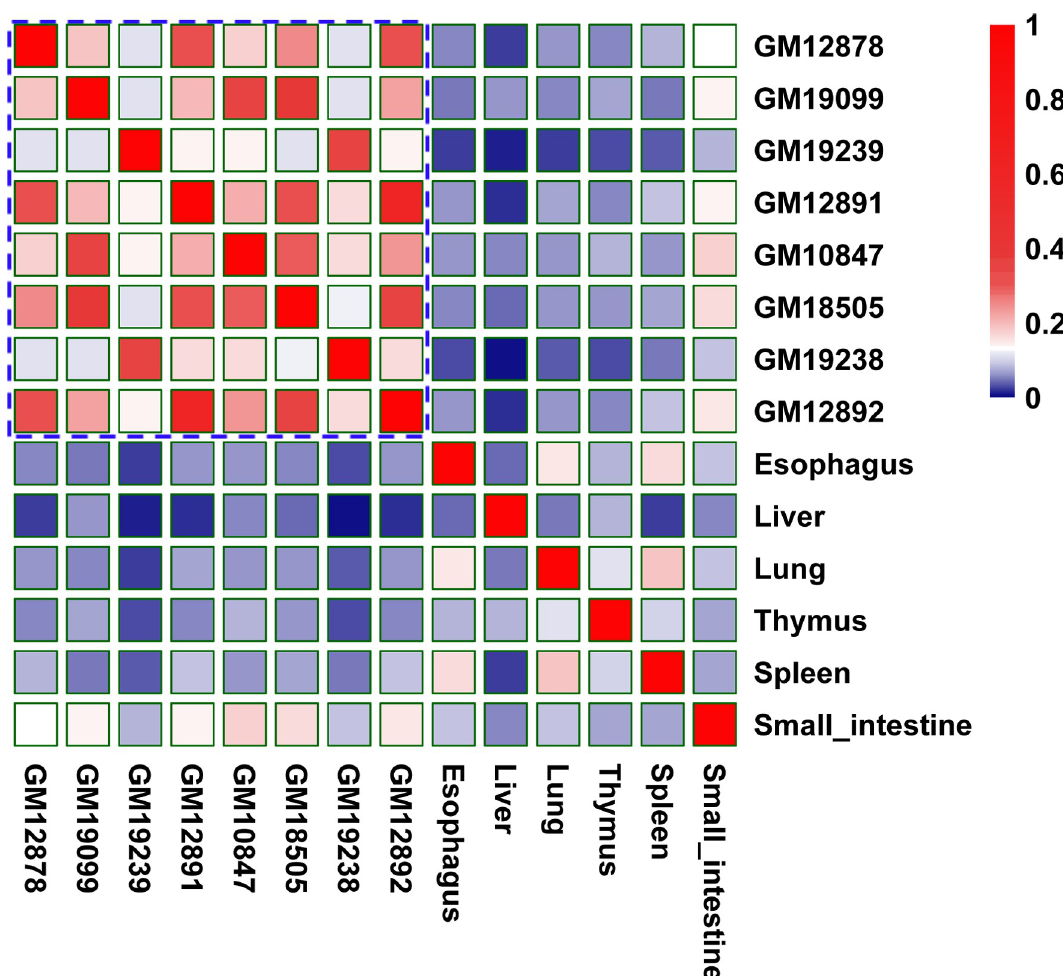
Fig 10. Patterns of predicted EG interactions across tissue/cell-types. Similarities were measured by Jaccard index across different/ similar tissue/cell types for EG interactions. For example, higher similarities are among blood cell lines, while other tissues displayed lower similarities with the other tissue/cell